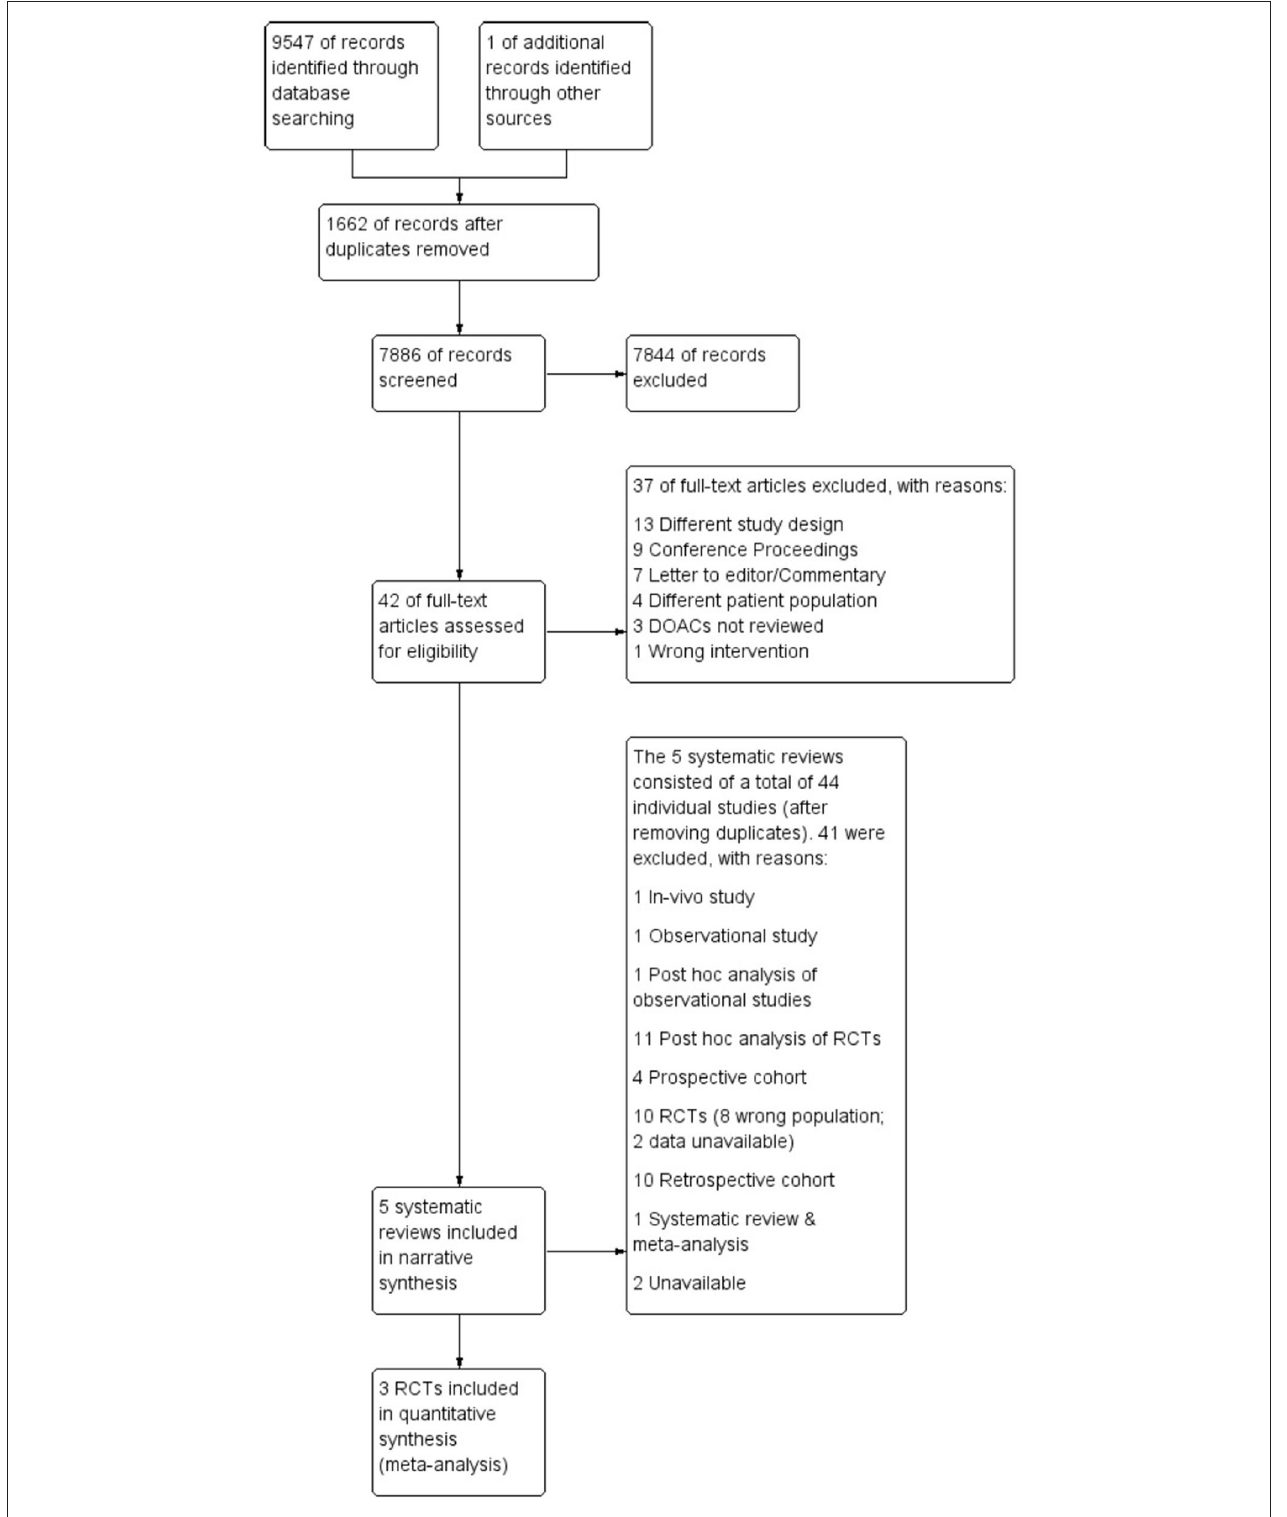
FIGURE 1 | PRISMA